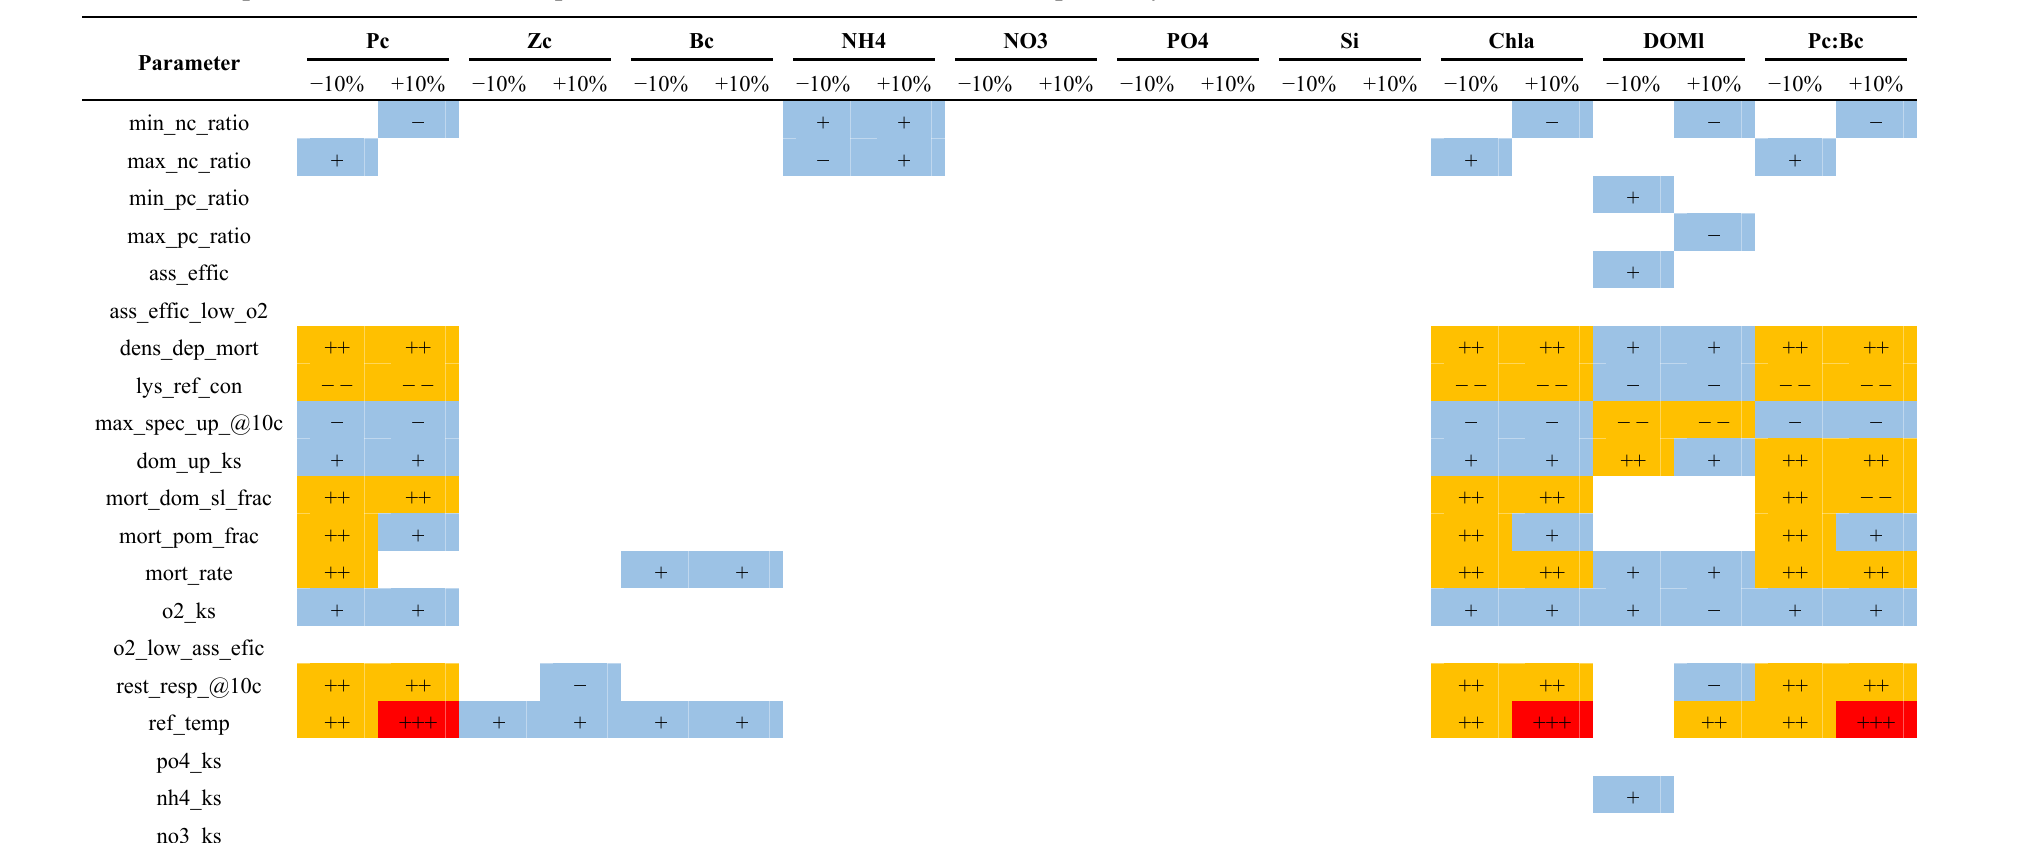
Table 12. SA result matrix for decomposers parameters impact on the analyzed variables. Color code: blue for sensitive ( S > 0.1), orange for highly sensitive ( S > 1) and red for extremely sensitive ( S > 10). The signs + and − stand for positive and negative perturbation, respectively. A description of the variables and parameters is found in Tables 1 and 4,